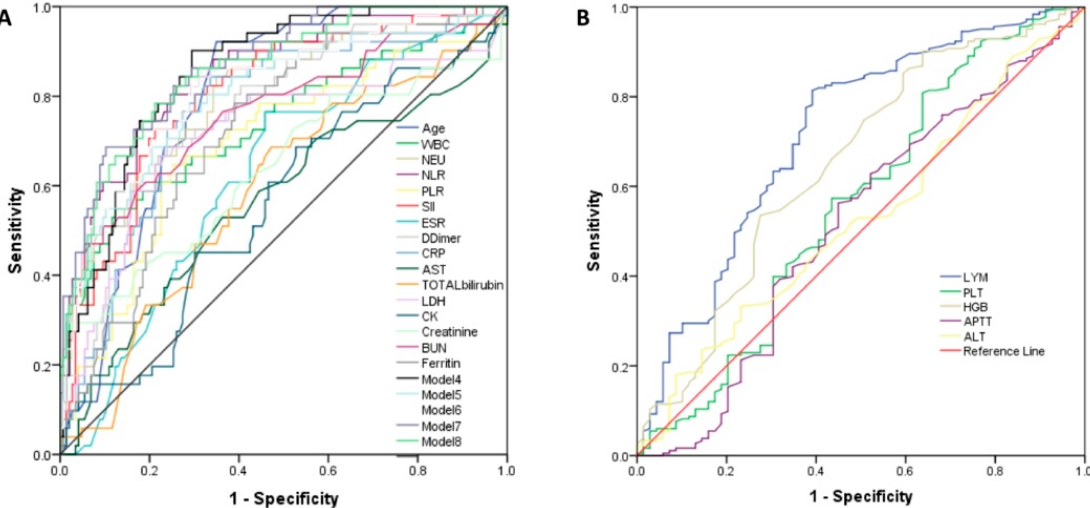
Figure 6. Receiver operating characteristic (ROC) curves for the individual laboratory parameters and models for prediction of mortality in COVID-19 patients. ( A ) The analysis of AUCs (area under the curve) for age, WBC, NEU, NLR, PLR, SII, ESR, D-dimer, CRP, AST, total bilirubin, LDH, CK, creatinine, BUN, ferritin, and models 4–8; ( B ) ALT, APTT, HGB, and